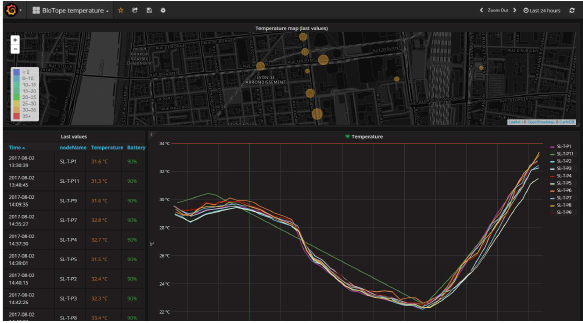
Figure 10. Dashboard of sensors and temperature readings (Grafana software).